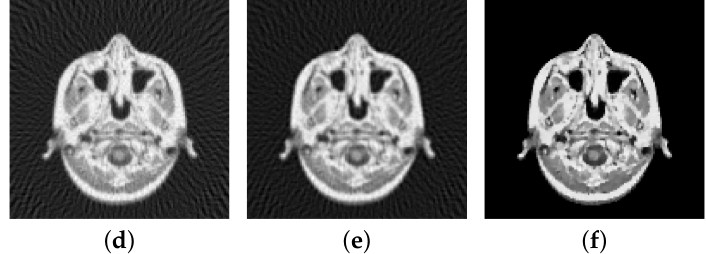
Figure 16. Reconstruction from noisy data. ( a ) Inverse Radon-transform (PSNR: 29.08; MSSIM: